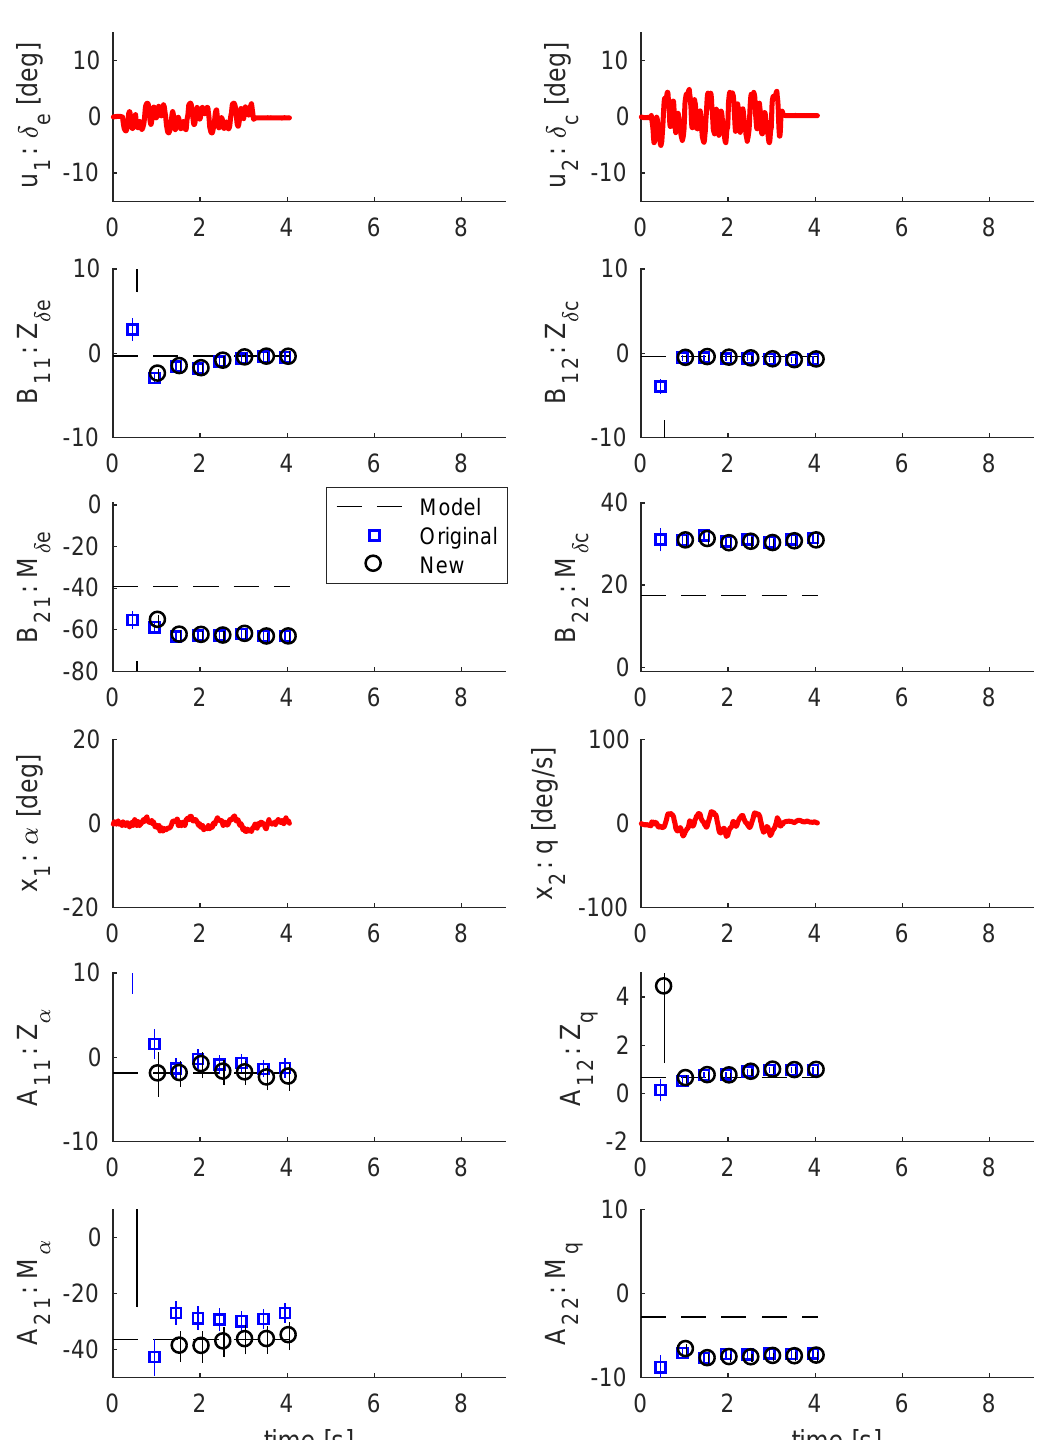
Figure 15. Results from flight FT. #2 with manoeuvre MSp1. The flight test data are shown in red, the results from the original method as blue squares and the results from the new method as black circles. The uncertainties are given as vertical bars. Note that the model (17) is not the true